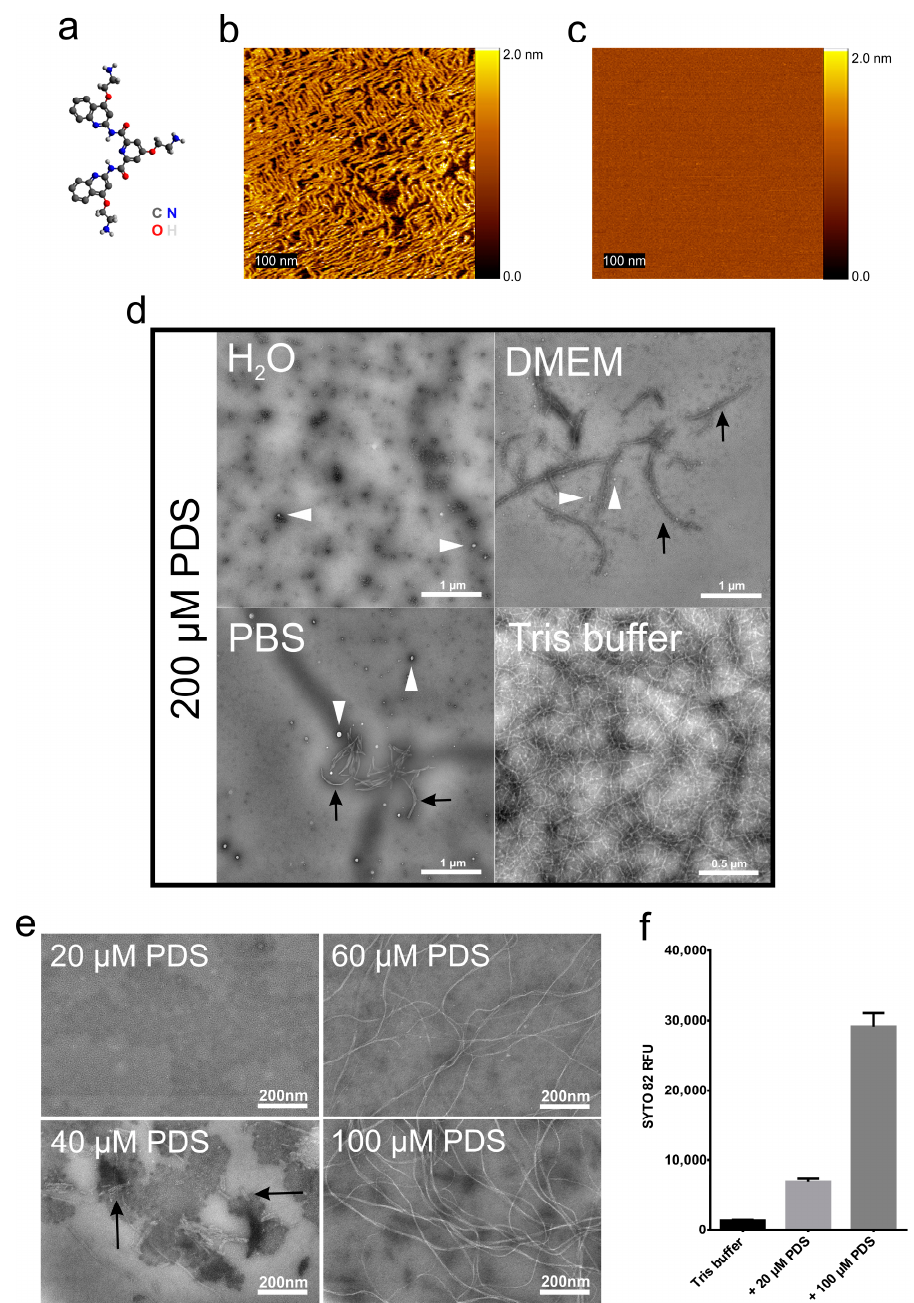
Figure 1. Formation of PDS fibrils under various conditions. ( a ) The structural formula of pyridostatin; for atom colour codes, see lower right. ( b ) PDS (4 µ M) in water was applied to freshly cleaved mica, incubated for 5 min, and viewed by AFM. ( c ) As ( b ) but with 4 µ M PDS in PBS instead of water. ( d ) PDS dissolved in the solutions indicated at 200 µ M was applied onto EM grids, stained with 2% phosphotungstic acid (pH 7.4), and imaged by TEM. The white arrowheads point to small amorphous aggregates, the black arrows to ‘protofibrils’. ( e ) PDS dissolved in Tris bu ff er at the concentrations indicated was applied to an EM grid, stained with 2% phosphotungstic acid (pH 7.4), and imaged by TEM. ( f ) SYTO82 at 5 µ M in Tris bu ff er +/ - PDS at the final concentrations indicated was transferred to a quartz cuvette and the fluorescence signal acquired at room temperature (excitation 541 nm ⁄ emission 560 nm). Data were analysed by one-way ANOVA with Tukey’s multiple comparisons, revealing that the values are significantly di ff erent from each other ( p < 0.05). n =